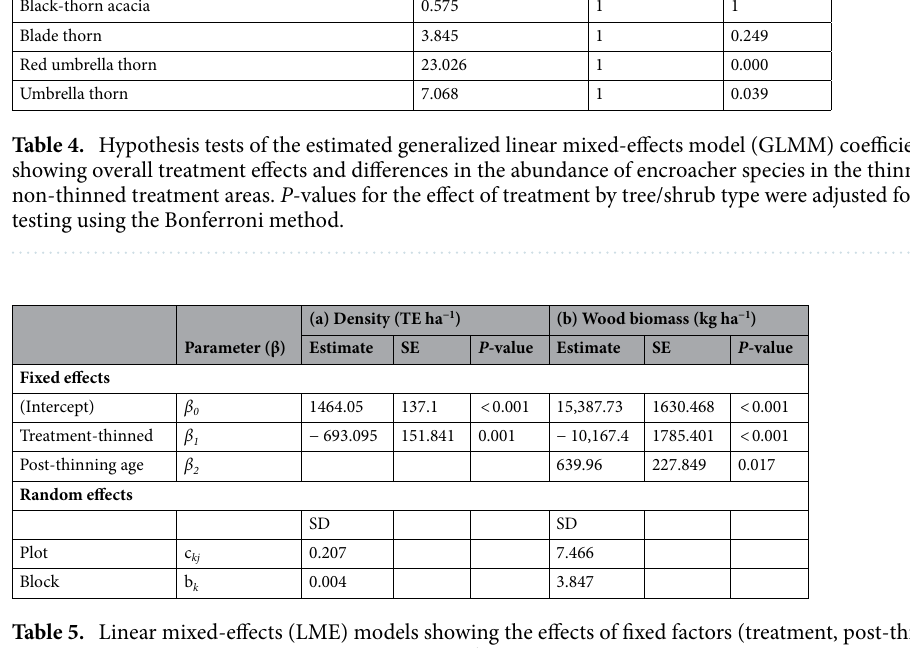
Table 5. Linear mixed-effects (LME) models showing the effects of fixed factors (treatment, post-thinning age) on (a) tree/shrub densities expressed as TE ha −1 , and (b) woody biomass of encroaching trees/shrubs.